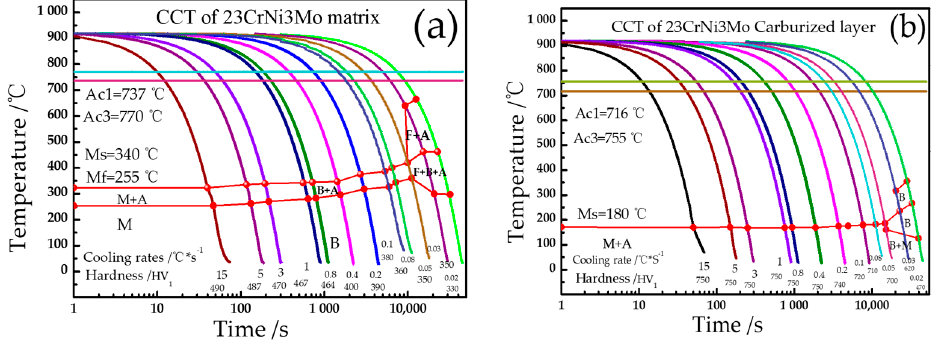
Figure 9. ( a ) CCT diagram of the matrix, and ( b ) CCT diagram of the carburised layer. Table 2. The phase transition temperature points of the carburised layer and the matrix. Series